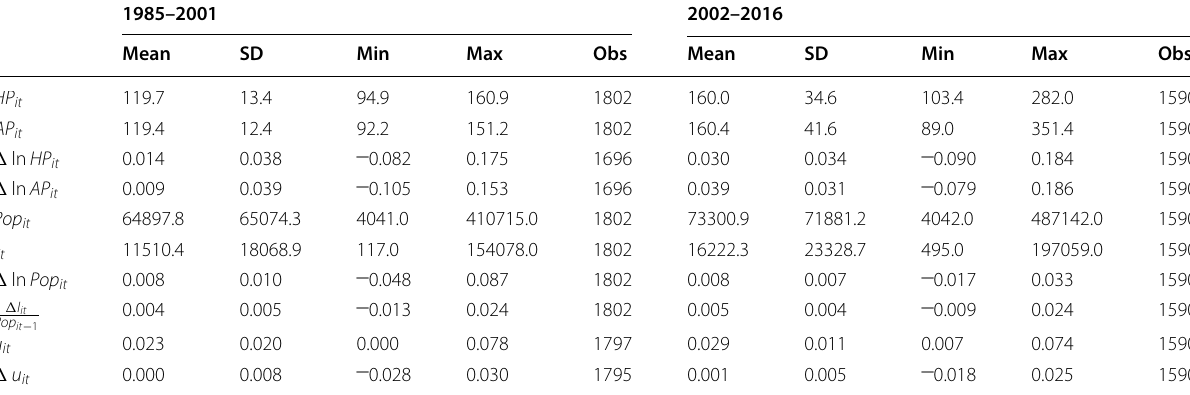
Table 2 Descriptive statistics at MS-level, 1985–2016. Source: Own calculations based on data from Wüest Partner and Federal Statistical Office